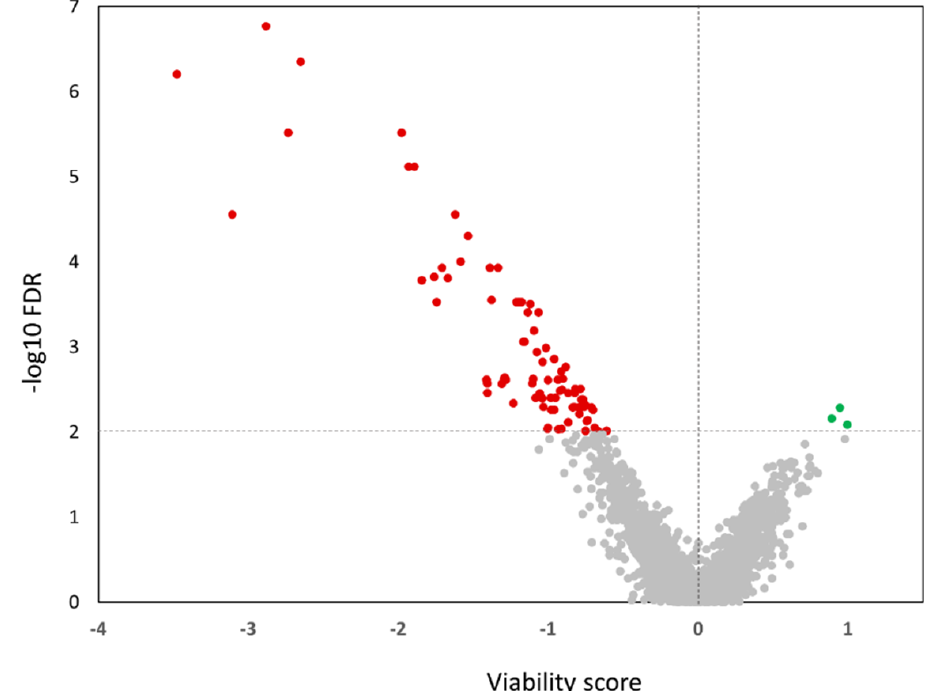
Figure 2. Volcano plot of viability scores in SiHa cells. The x-axis specifies the difference in viability scores, and the y-axis specifies the negative logarithm to the base 10 of the FDR. The horizontal dashed red line indicates the selection threshold: FDR < 0.01. miRNA hits with decreased and increased viabilities are marked red and green, respectively.